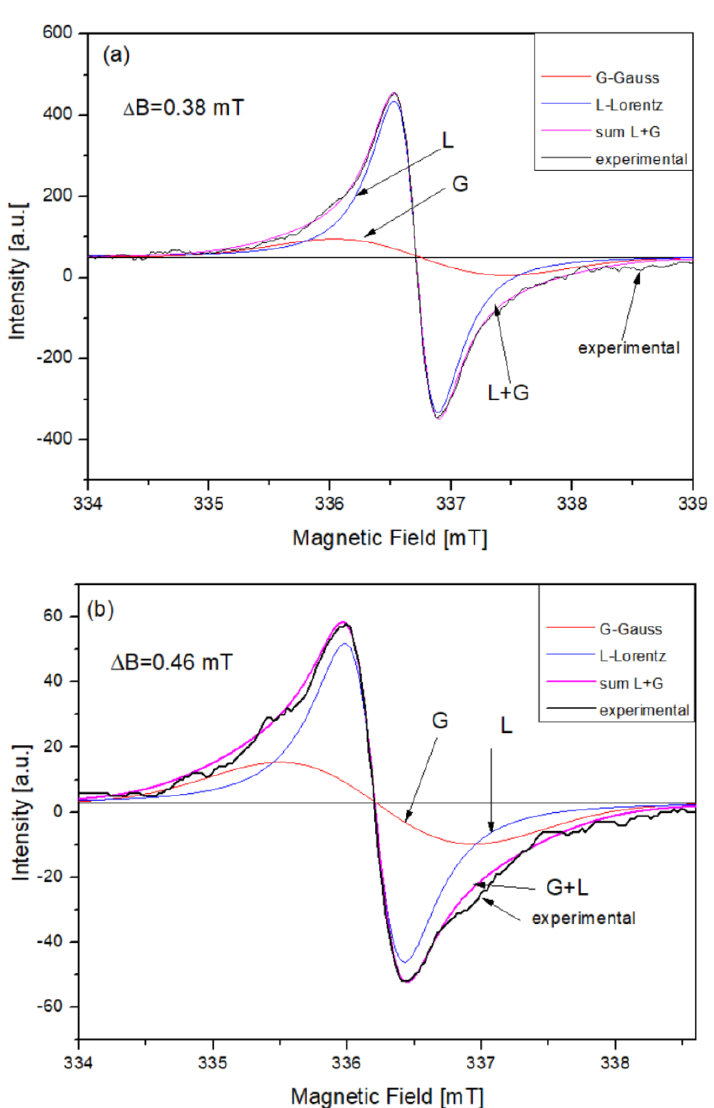
Figure 2. The deconvoluted EPR spectra recorded for samples: ( a ) extracted from forest soils and ( b ) isolated from incubated samples of plant material. ∆ B —peak-to-peak width of experimental line. G—Gaussian; L—Lorentzian components; G + L—sum of both components. (The accuracy of the numerical fitting in this case is better than 0.99 correlation coefficient).